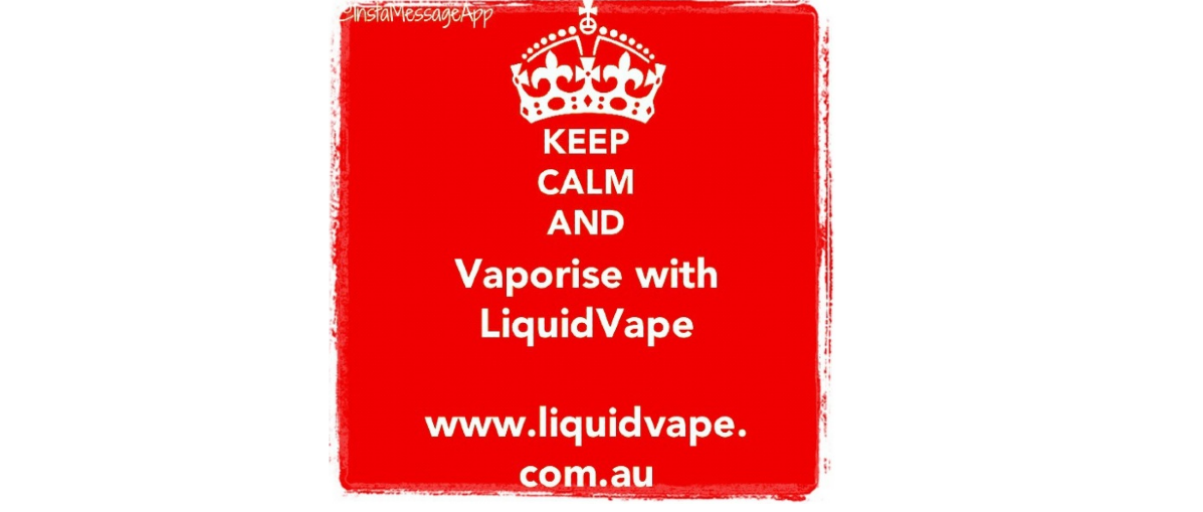
Figure 2. Example within the nonmonetary promotional offer category of the "promotional practices and strategies" domain.